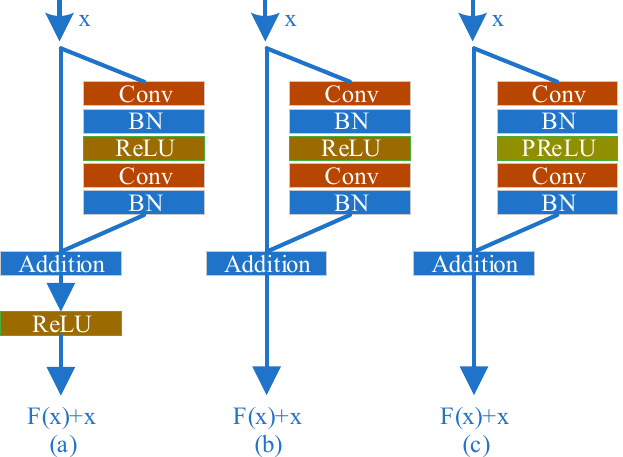
Figure 2. ( a ) Original residual block [36–38]. ( b ) S. Gross and M. Wilber [39]. ( c ) RResblock. Where “Conv” denotes convolution and “BN” denotes Batch Normalization.